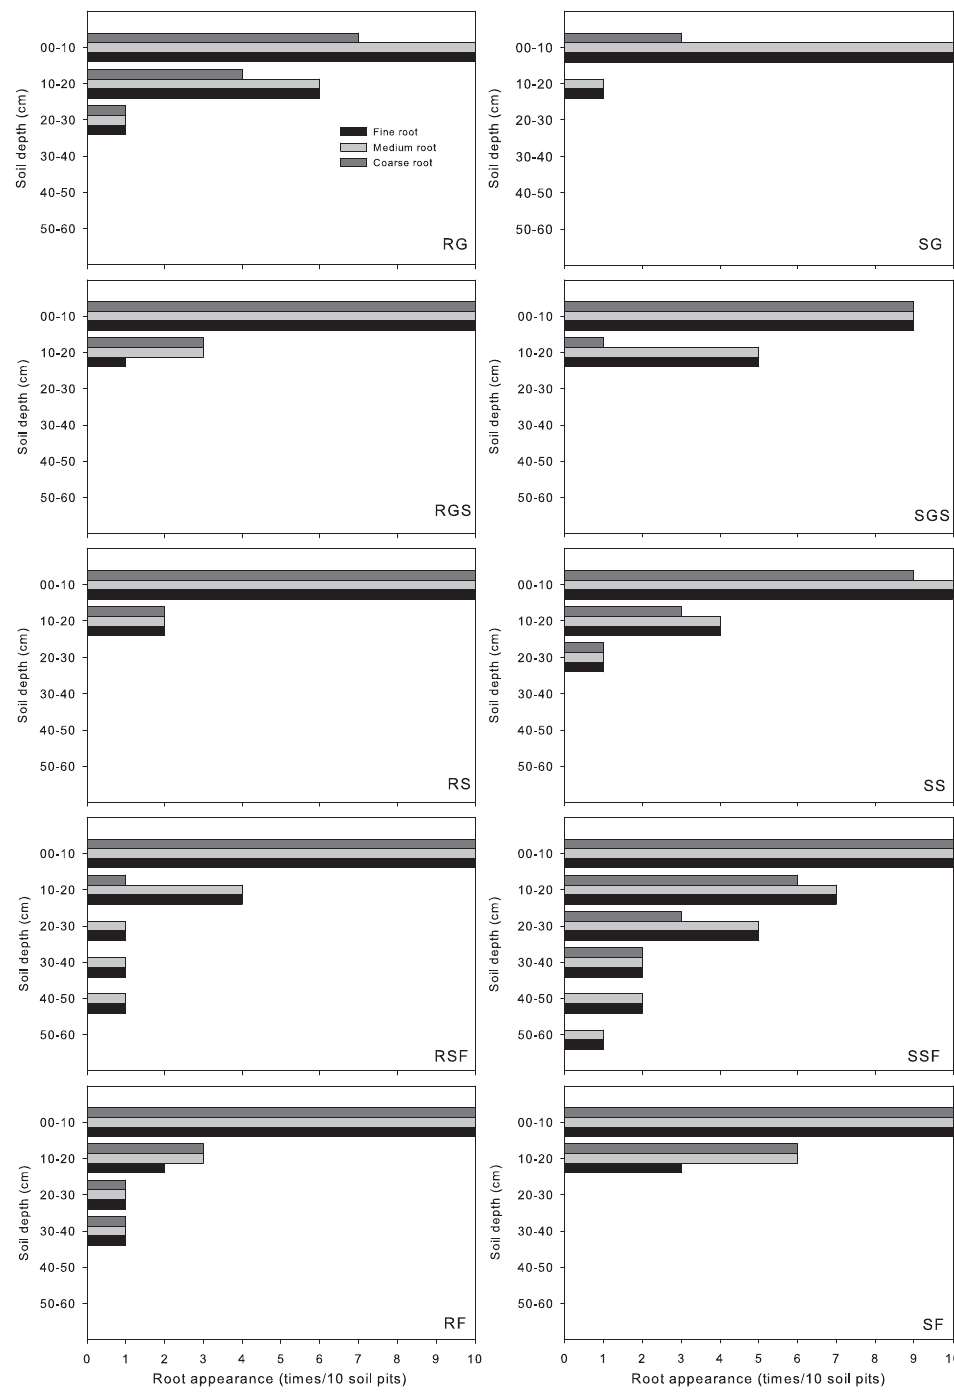
Figure 2. Frequency of root appearance in soil layers. Note that the total number of plots for root biomass sampling is 10 in each vegetation type. A value of 10 indicates that roots occur in this soil layer in all 10 plots. A value of 0 indicates that no roots occurred in this soil layer in all 10 plots. RG: rock-dominated grassland; SG: soil-rich grassland; RGS: rock-dominated grass–scrub tussock; SGS: soil-rich grass–scrub tussock; RS: rock-dominated thorn–scrub shrubland; SS: soil-rich thorn–scrub shrubland; RSF: rock-dominated scrub–tree forest; SSF: soil- rich scrub–tree forest; RF: rock-dominated mixed evergreen and deciduous forest; SF: soil-rich mixed evergreen and deciduous forest.